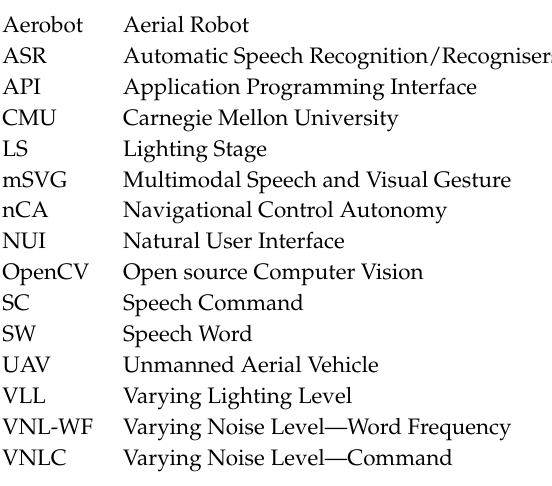
Table S1: Varying Noise Levels—Commands, Table S2: Varying Noise Levels—Word Frequency, Table S3: Varying Lighting Levels—Finger